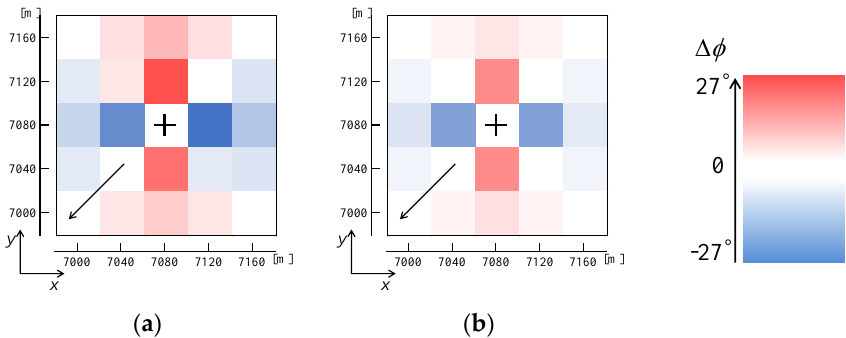
Figure 7. Color-coded azimuth error (in degrees) due to the presence of a nearby conducting structure having a height of 60 m and a square cross-section of 40 m × 40 m for the case of true azimuth φ equal to 45° and current risetimes equal to ( a ) 0.5 μs and ( b ) 3 μs.